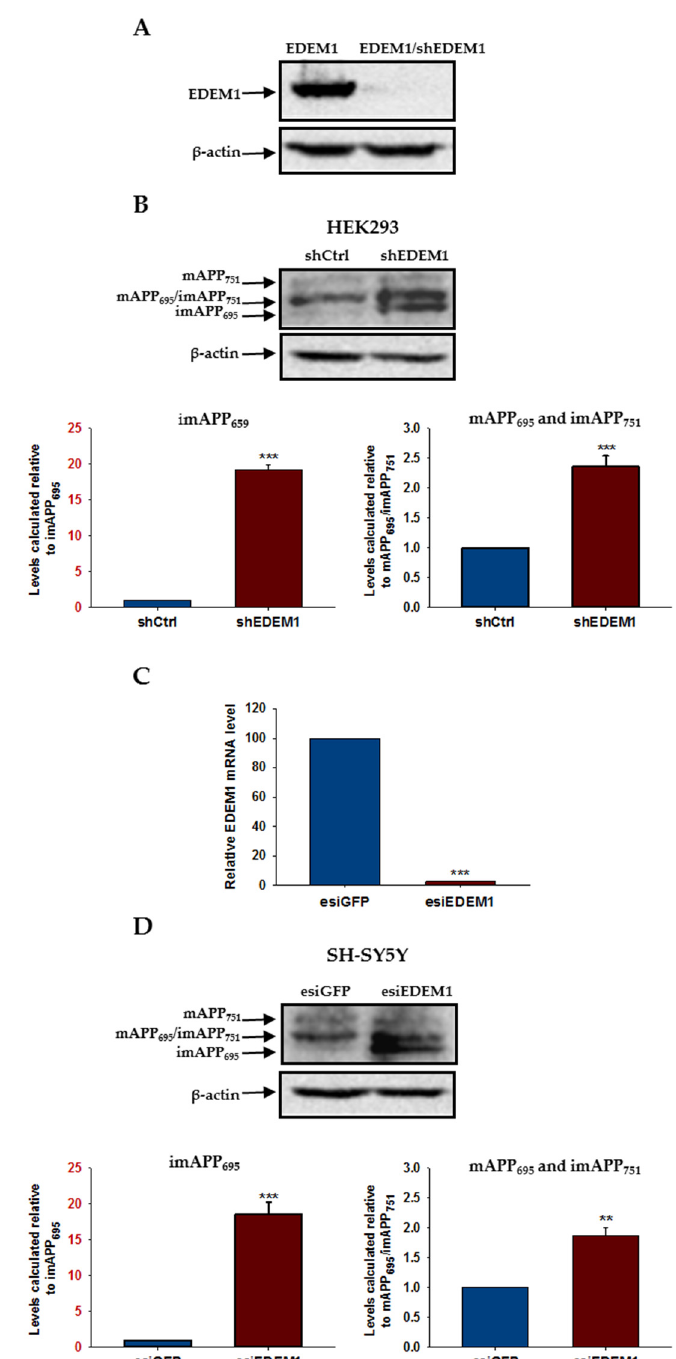
Figure 7. APP isoform levels are increased in HEK293 and SH-SY5Y cells with downregulated EDEM1. EDEM1 mRNA levels were analyzed by qRT-PCR or Western-blotting. ( A ) Western blotting of EDEM1 and actin in HEK293 cells transfected with EDEM1 or cotransfected with EDEM1 and shEDEM1 construct. Representative experiment is shown. ( B ) Western blotting of APP and actin in lysates of HEK293 cells with or without downregulated EDEM1 (as indicated). Representative experiment is shown for cells transfected with shEDEM1 or control shRNA (shCtrl). Mature APP is abbreviated as mAPP, and immature APP as imAPP. The level of APP isoforms was quantified and is shown in the graphs. Values obtained for lysates of cells without EDEM1 downregulation are indicated as 1. Values representing cells with reduced levels of EDEM1 are plotted relative to 1. Note that the scale of the Y axis for both graphs is not the same. The Y axis scale for imAPP 695 is highlighted in red. The values are expressed as mean ± SD, n = 3, ** p ˂ 0.01, *** p ˂ 0.001, Student’s